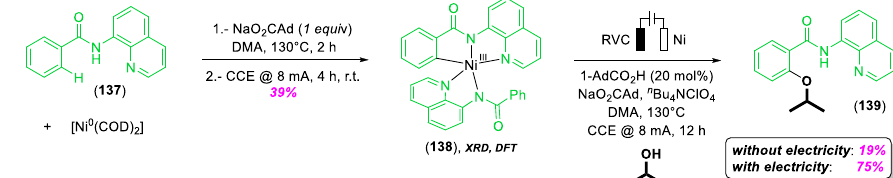
Scheme 34. Synthesis of the σ -aryl-Ni III intermediate 138 , and 138 -enabled C(sp 2 ) – O i Pr bond formation in the presence or absence of electricity. Adapted from reference